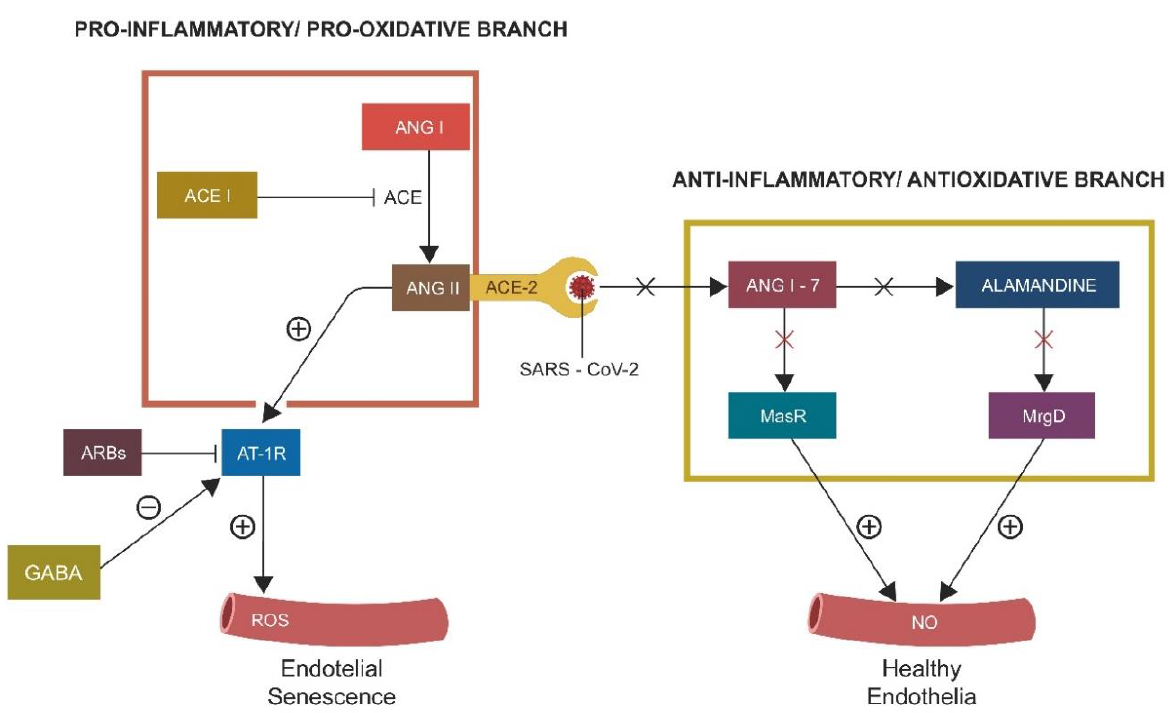
Figure 2. Human RAS consists of two opposing branches, the proinflammatory/prooxidative (driven by ANG II) branch and the anti-inflammatory/antioxidant (driven by ANG 1-7) one. ANG II, acting via AT-1Rs, induces EC senescence. ARBs and GABA negatively regulate AT-1Rs, opposing ANG II. The protective RAS branch, comprised of ANG 1-7, alamandine, and their respective receptors Mas and MrgD, inhibit inflammation and oxidative stress. SARS-CoV-2 engagement with ACE-2 disrupts the entire anti-inflammatory/antioxidant branch, leading to unchecked ANG II accumulation and premature EC senescence. Legend: ANG I, angiotensin I, ACEi, angiotensin-converting enzyme inhibitors, ANG II, angiotensin II, ARBs, angiotensin receptor blockers, AT-1r, angiotensin receptor type 1, ROS, reactive oxygen species, ANG1-7, angiotensin 1-7, MasR, Mas receptor, MrgD, MrgD receptor, NO, nitric oxide.